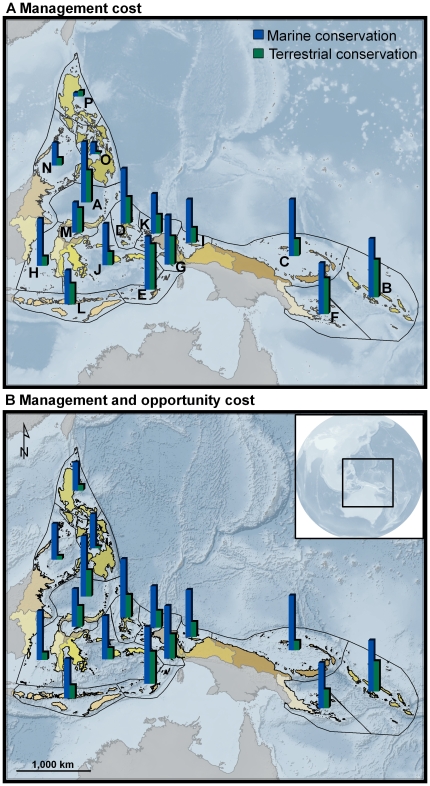
Ecoaction rankings indicate their relative priority for coral reef conservation investment across the Coral Triangle (taller bar, higher rank).Scenario 1 (a) reflects investment of management costs whereas scenario 2 (b) also considers opportunity costs. Letters labeling ecoregions follow the ranking order for marine conservation (i.e. Ecoregion A ranks highest for marine conservation) and correspond to letters in Figure 3.